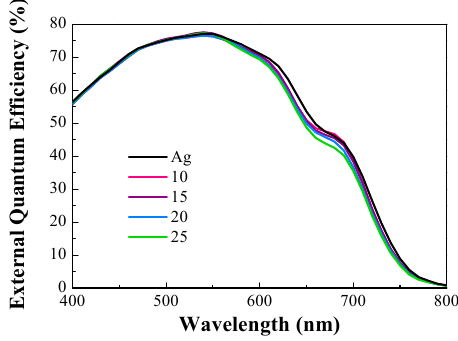
Figure 5. External quantum efficiency (EQE) curves of p-i-n solar cells with Ag and AlTi films prepared at different pressures.